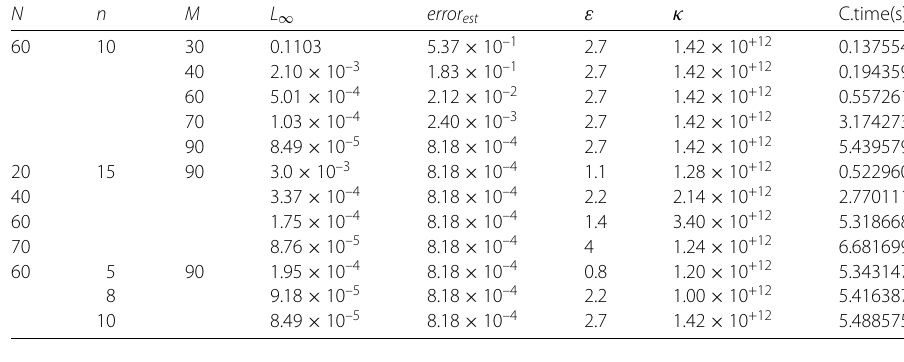
Table 4 The results are obtained for α = 0.7, x ∈ [–1,1], and t = 1